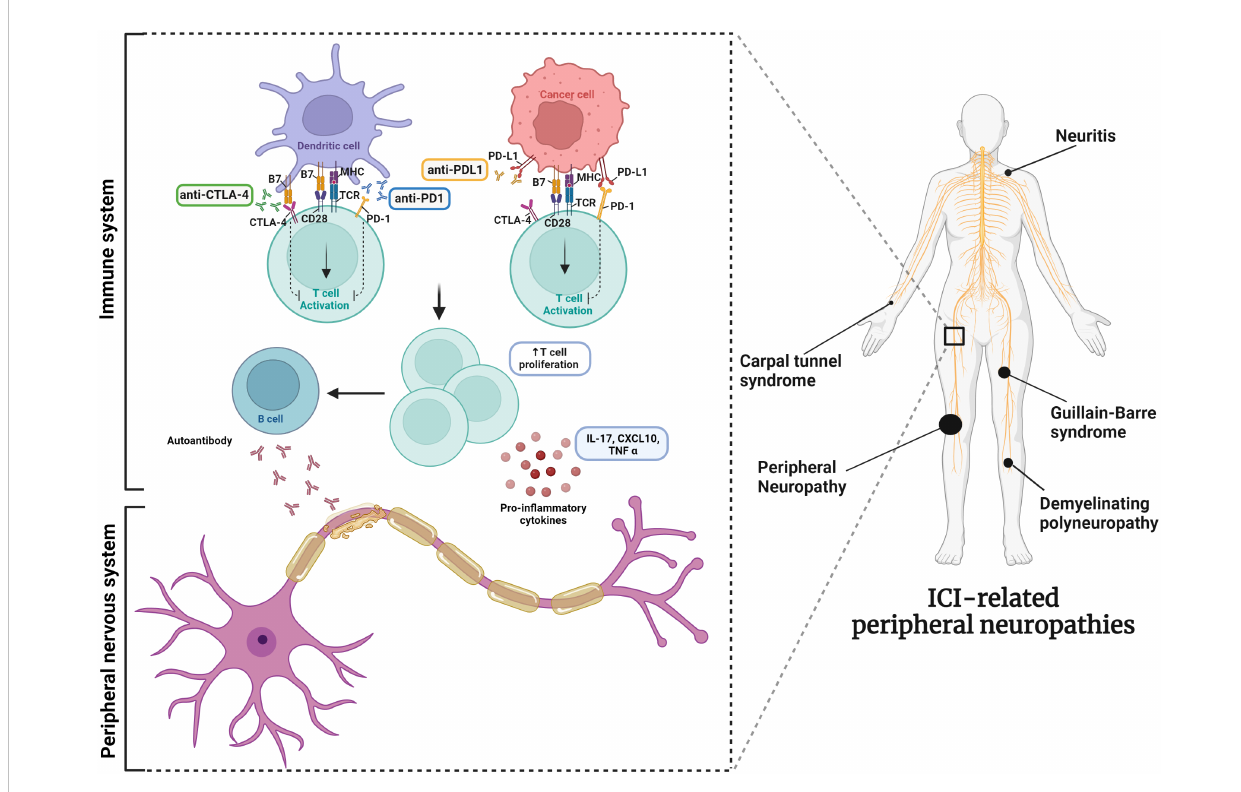
FIGURE 1 The mechanism of action of ICIs and possible associated